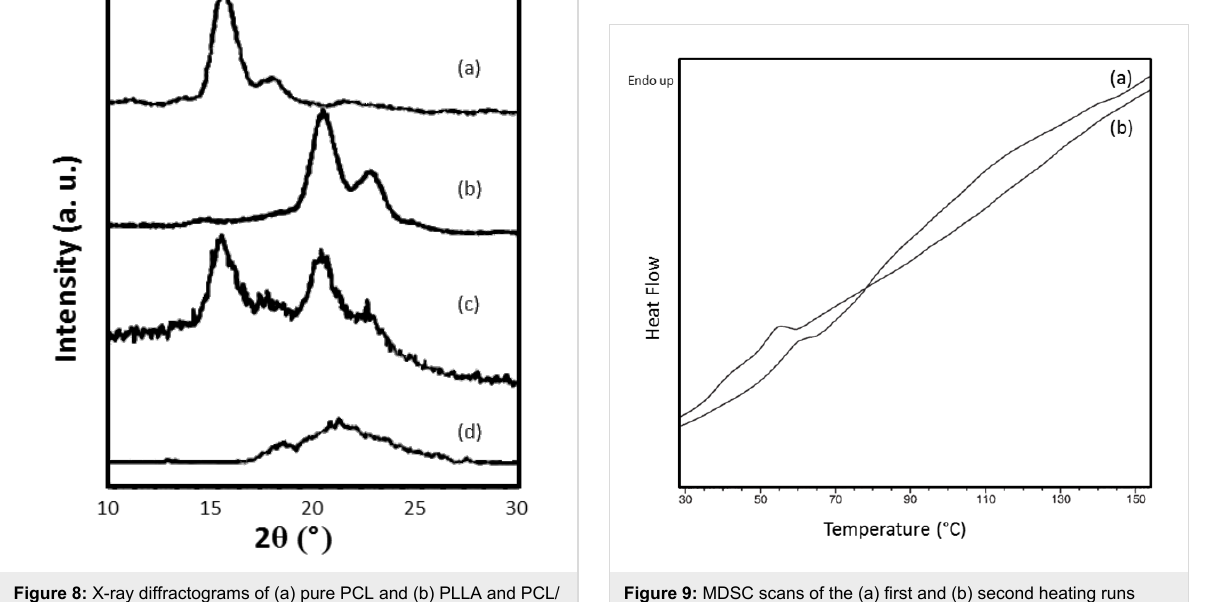
Figure 9: MDSC scans of the (a) first and (b) second heating runs recorded for the PC/PMMA/PVAc-2 blend. The sample was held for 3 min at 170 °C after the first heating